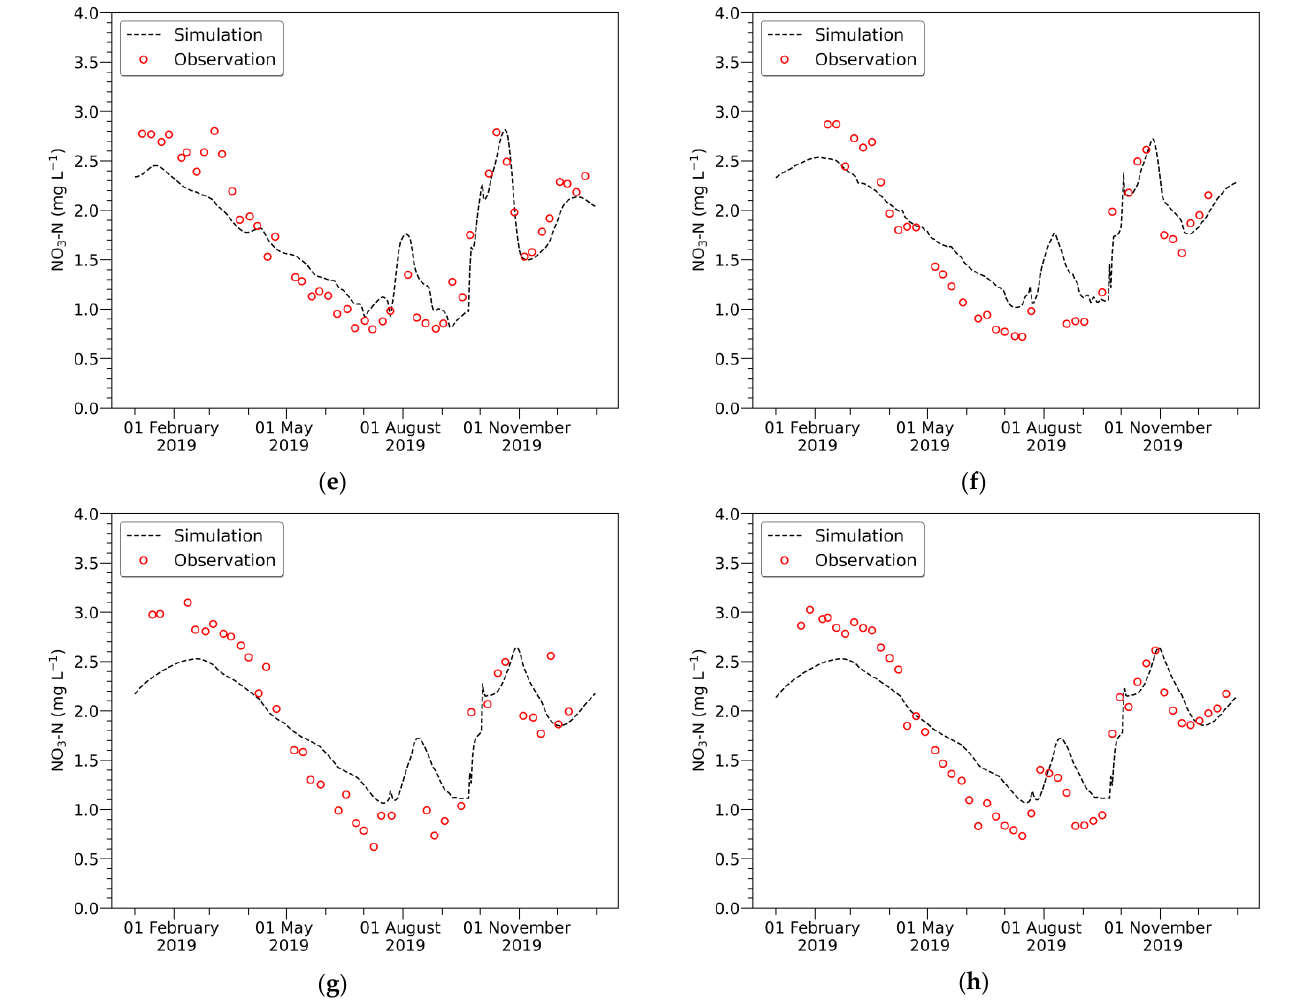
Figure 6. Graphs showing the difference between simulation and observation of the NO 3 -N concen- tration for calibration. ( a ) Cross section 658; ( b ) cross section 620; ( c ) cross section 559; ( d ) cross section 517; ( e ) cross section 503; ( f ) cross section 459; ( g ) cross section 427; ( h ) cross section 416.